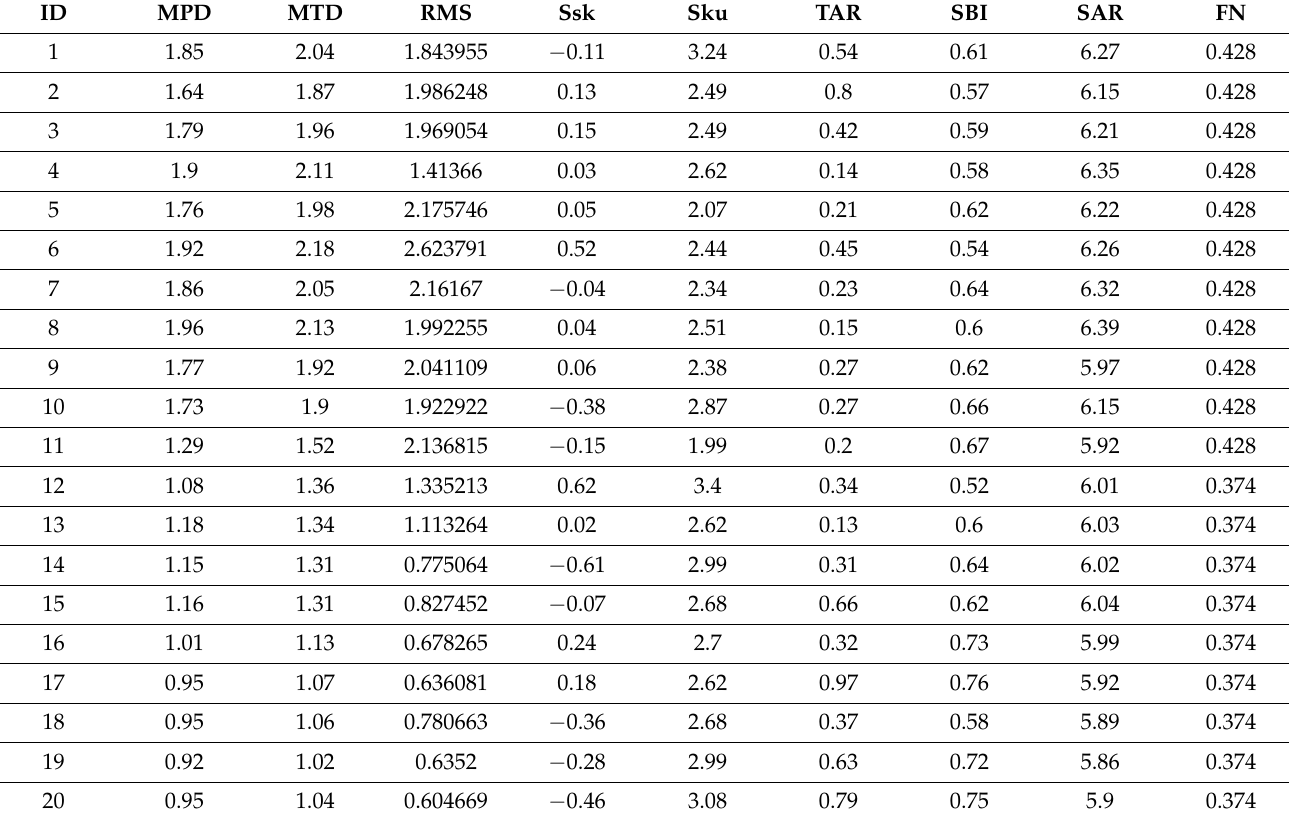
Table A1. The 195 pairs of 3D texture parameters and DFT friction numbers for model